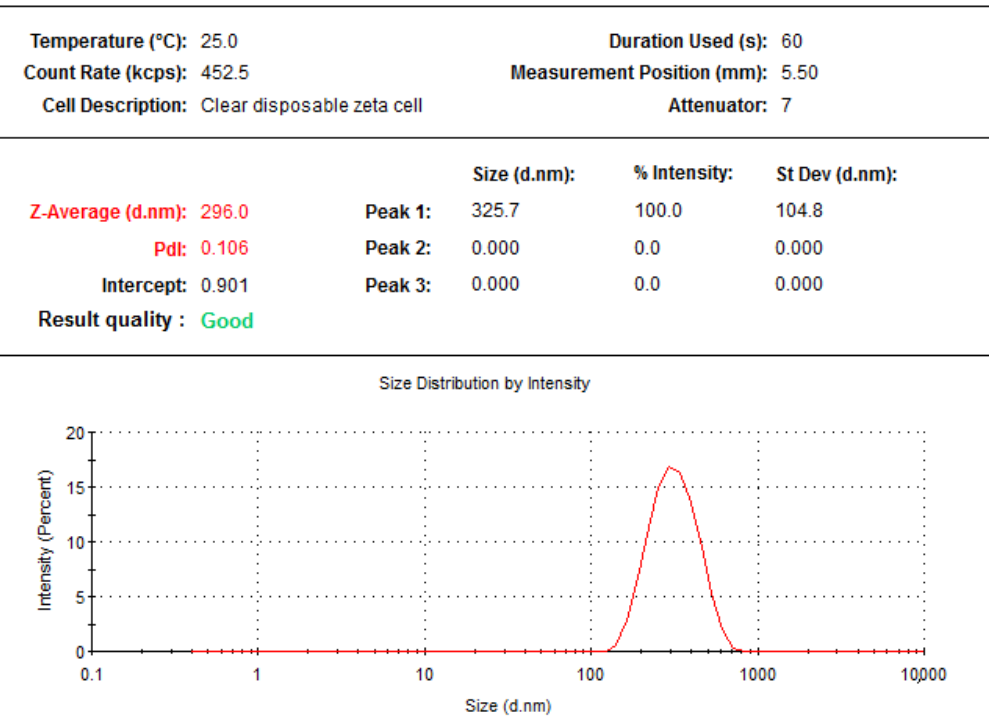
Figure 3. The average particle size and PDI of optimized MoP formulation.